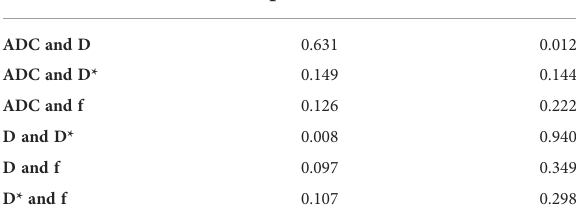
TABLE 2 Correlations between ADC, D, D*, and f of IVIM-DWI parameters.